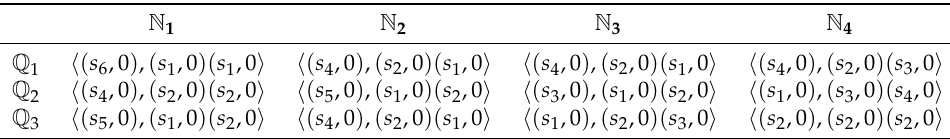
Table 1. The 2-tuple picture fuzzy linguistic decision matrix.